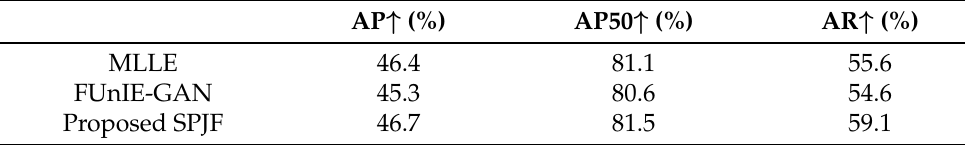
Table 5. The experimental results obtained on the enhanced URPC2021